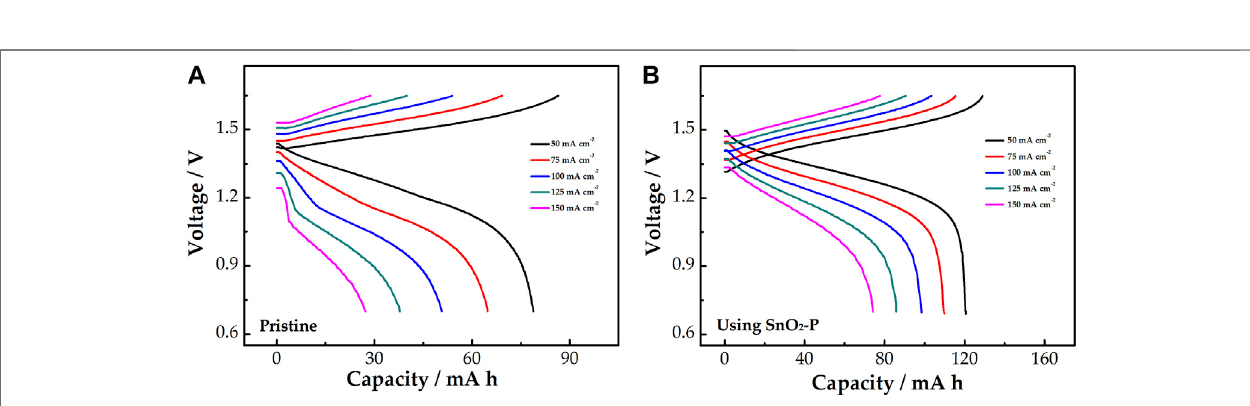
Frontiers in Chemistry |